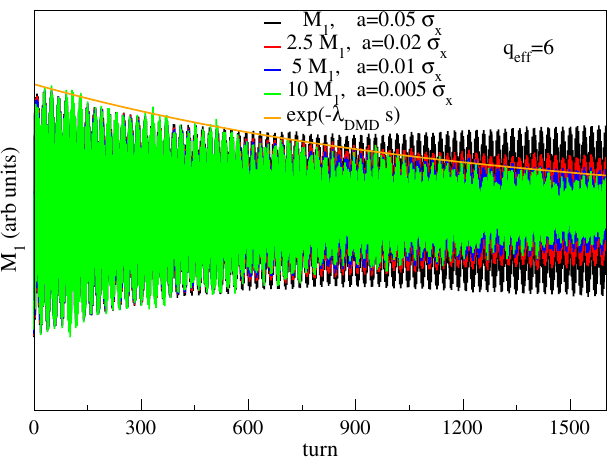
FIG. 10. 3D-G bunch. M 1 , Eq. (36), versus turn number at q ¼ 6 for different excitation amplitudes. M 1 is multiplied by a eff factor inverse proportional to the excitation amplitude. The linear regime requires an excitation amplitude smaller than 0 . 01 σ x . The exponential decay in the linear regime is consistent with the one provided by the DMD analysis. In the nonlinear regime the long- time behavior is very sensitive to the excitation